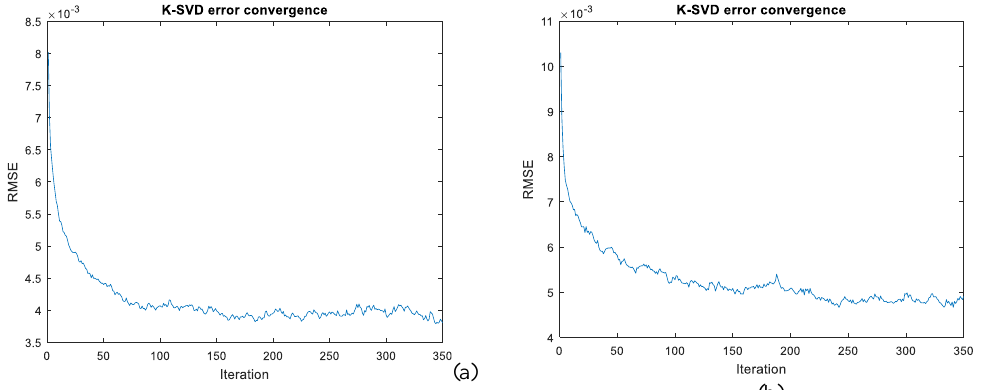
Figure 5. Convergence plot of the proposed dictionary learning algorithm using the HOG features: a) for Tarom rice data B) for Shiroodi rice